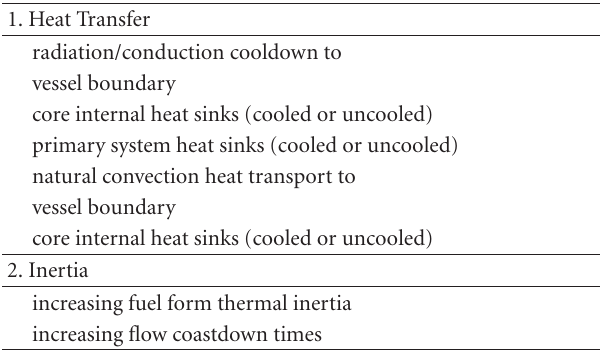
Table 1: Passive decay heat removal